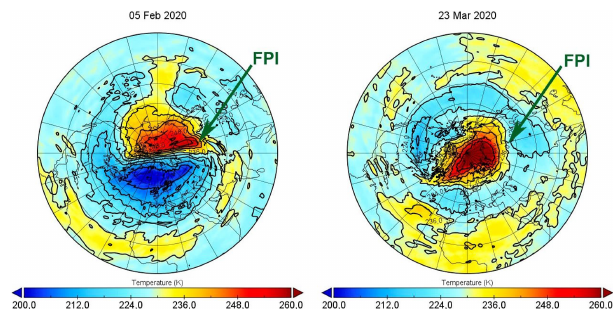
Figure 13. Same as Fig. 4.